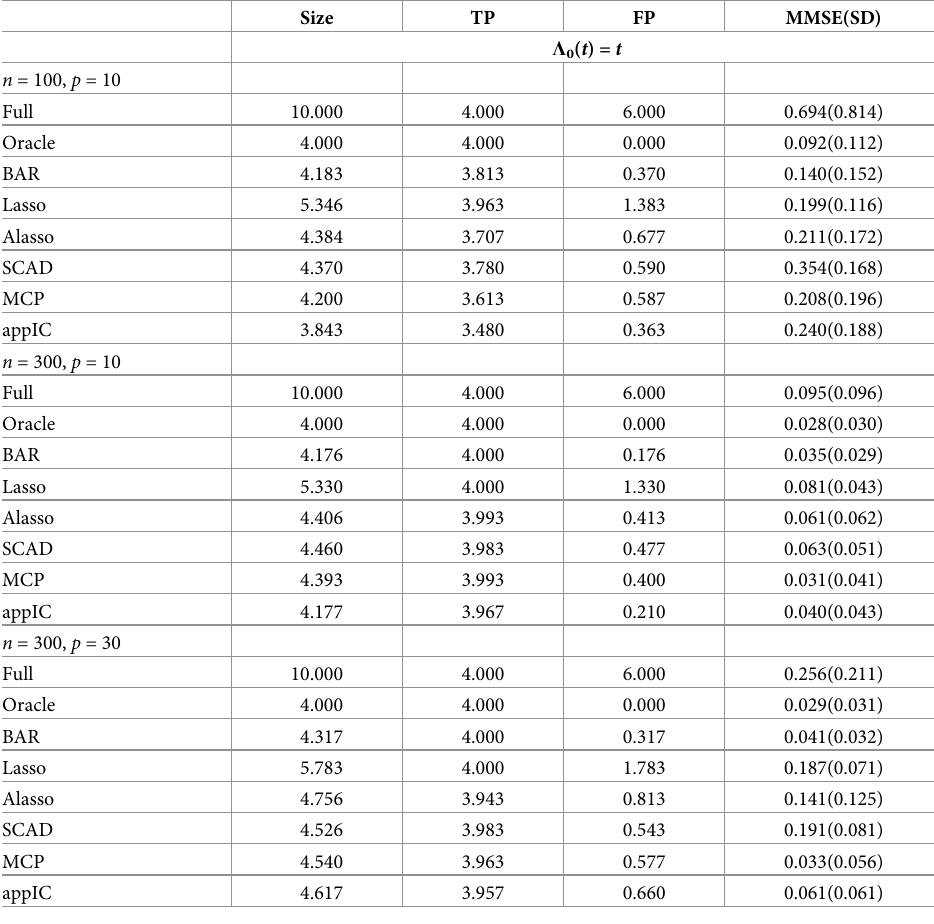
Table 6. Estimation results with different